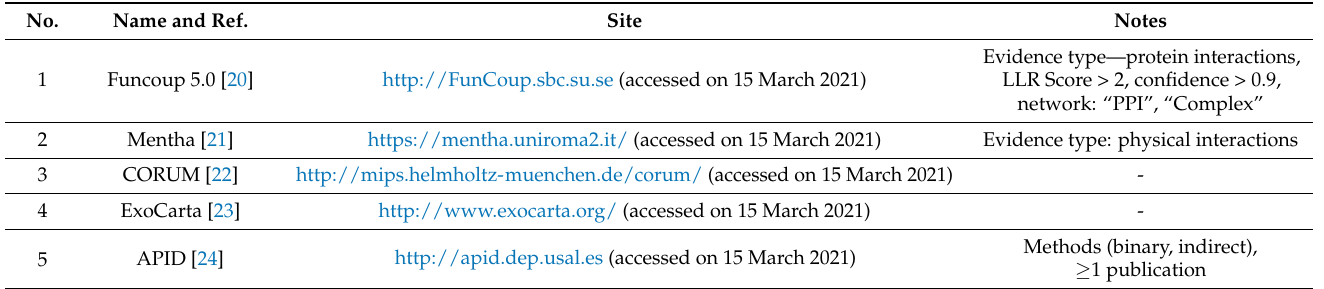
Table 1. Interactome browsers for retrieving protein–protein interactions